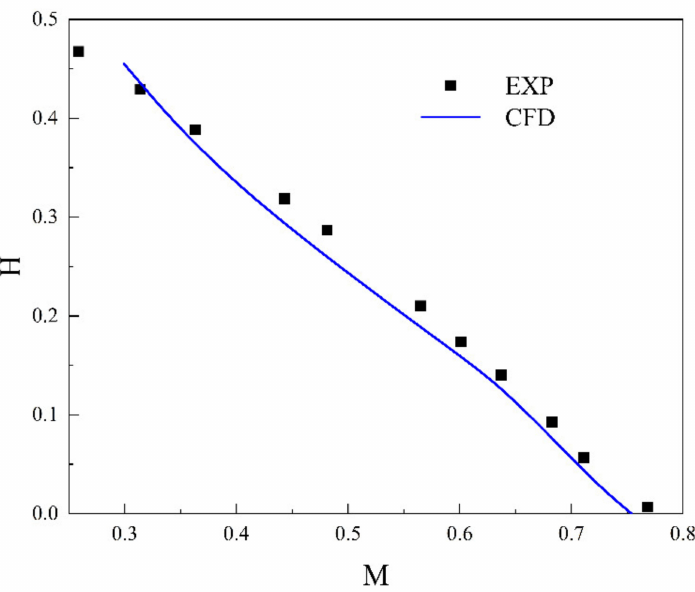
Figure 4. Comparison of the CFD results and the experimental data [43]. (The data points were extracted from the